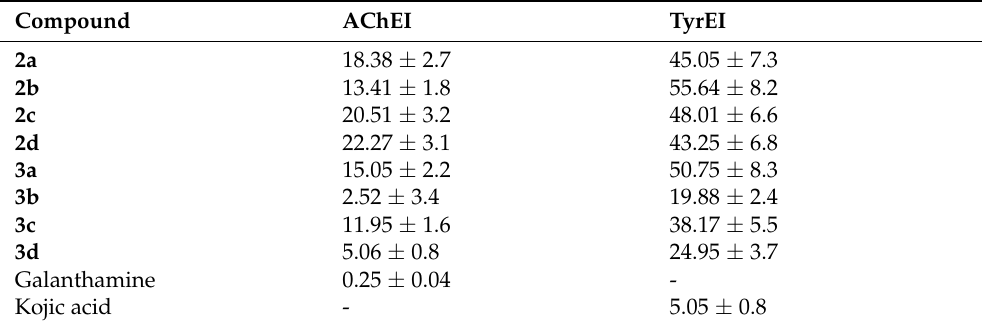
Table 1. Anti-AChRi and anti-TyrEI inhibitory activity of the synthesized compounds IC 50 in μM mL −1 of mean ± S.D.